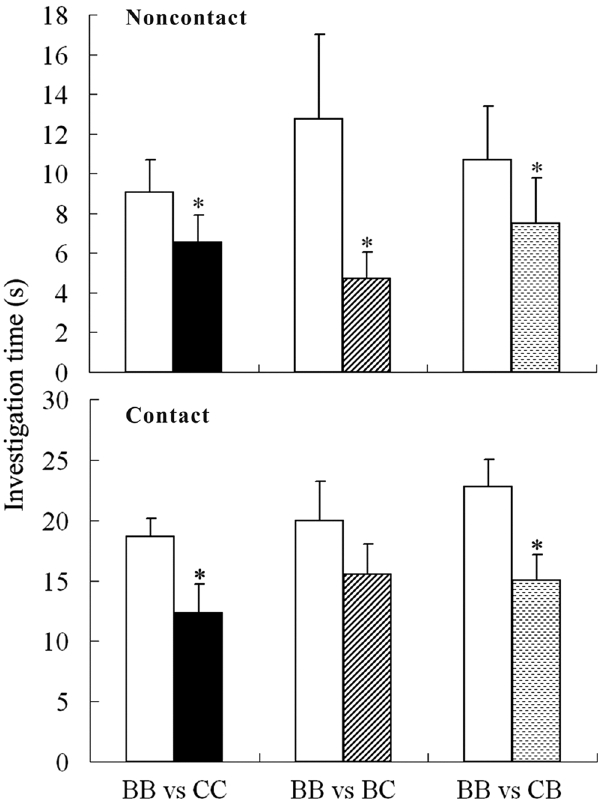
Figure 4. Responses of female C57BL/6 to male urine from different strains. In each test, mice were presented with two urine samples, one from BB and the other from CC, BC or CB mice. * Indicates a significant difference between the investigation times in each trial. The data are presented as the mean ± SE, n = 16 in each